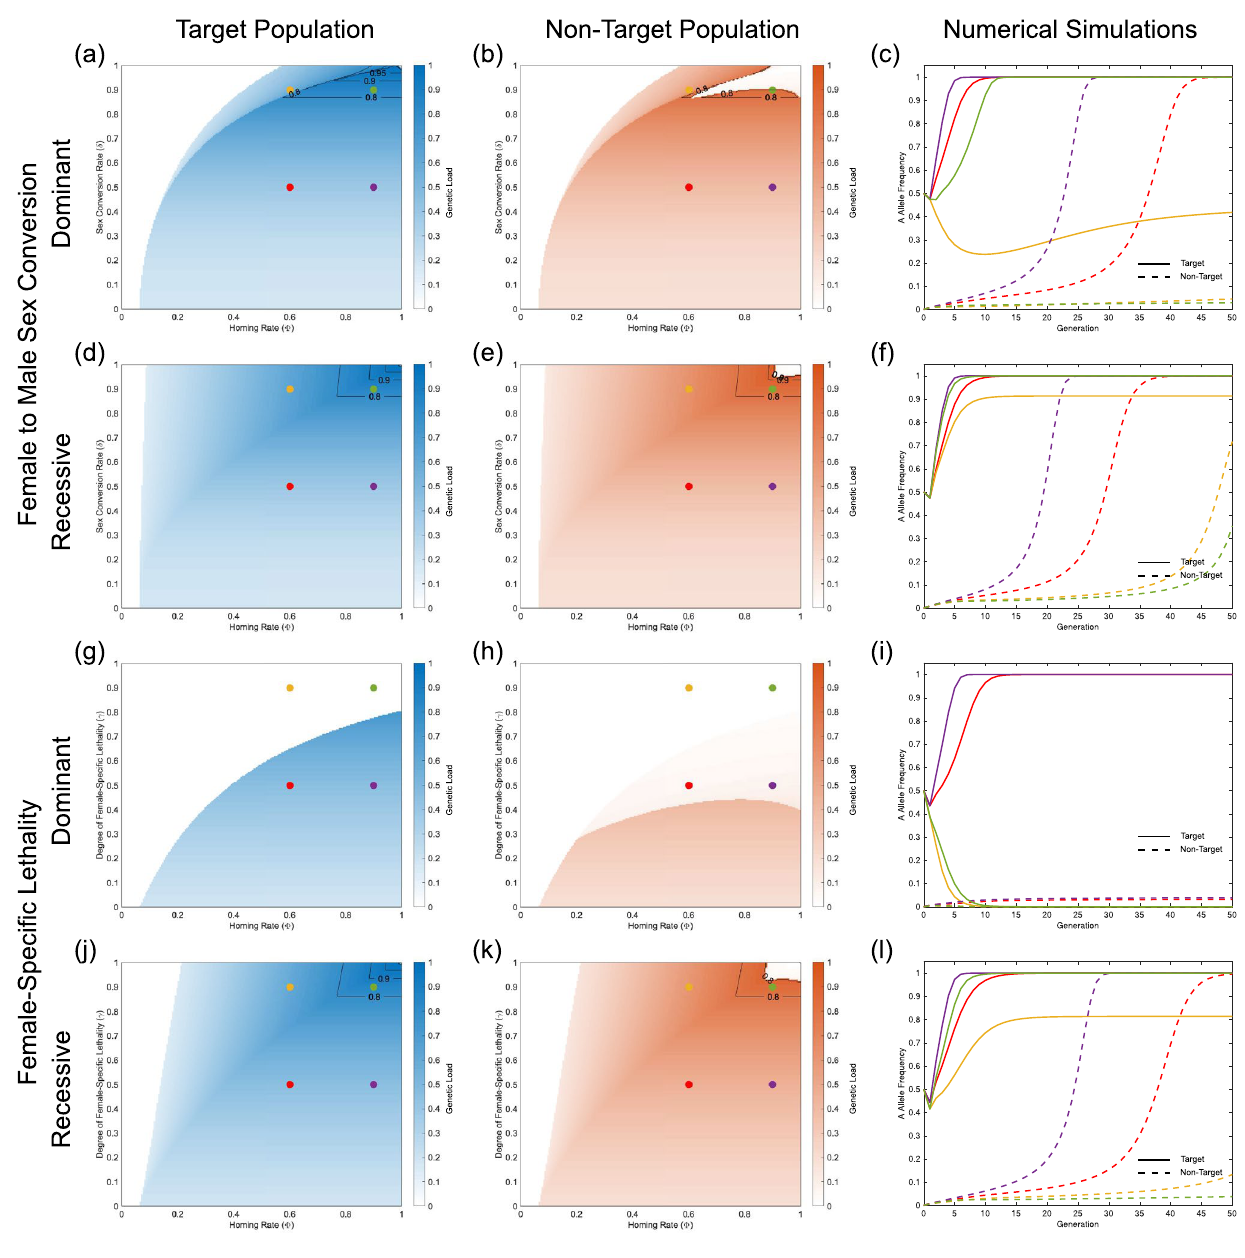
Figure 6. SDKR can, under certain conditions, achieve significant and localised population suppression. Results shown are for strategies based on dominant ( a – c ) or recessive ( d – f ) female to male sex conversion and dominant ( g – i ) or recessive ( j – l ) female-specific lethality. Heat maps display the equilibrium genetic load imposed on a target (left column; blue) and a non-target population (centre column; orange). Black contour lines are shown for genetic loads of 80%, 90%, 95% and 99%. Here, the equilibrium state is assessed 1000 generations after the release of transgenic individuals. The right column shows specific examples for parameter combinations indicated by coloured dots in the left and centre columns (i.e. combinations of homing rate (cid:31) = 0.6 or 0.9 and female to male sex conversion ( δ = 0.5 or 0.9) or female-specific lethality ( γ = 0.5 or 0.9)). Solid lines represent transgene allele frequencies in a target population and dashed lines are the equivalent for a non-target population. In all cases, simulations consider a relative fitness of ε = 0.95 per construct (applied multiplicatively) and fully penetrant lethal effects (i.e. L = 1 ). In each case we consider the release of individuals homozygous for both transgenic constructs and fitness costs that are applied multiplicatively. Migration is considered to be unidrectional at a rate of 2% per generation. It is also worth noting that fitness costs associated with transgenic constructs can produce a small genetic load even where sex conversion and/or female-specific lethality are absent. Supplementary Figures S1 and S2 show equivalent results for fitness costs of 15% and 10% per construct, respectively and demonstrate the importance of fitness costs in determining the ability of such systems to produce confined population